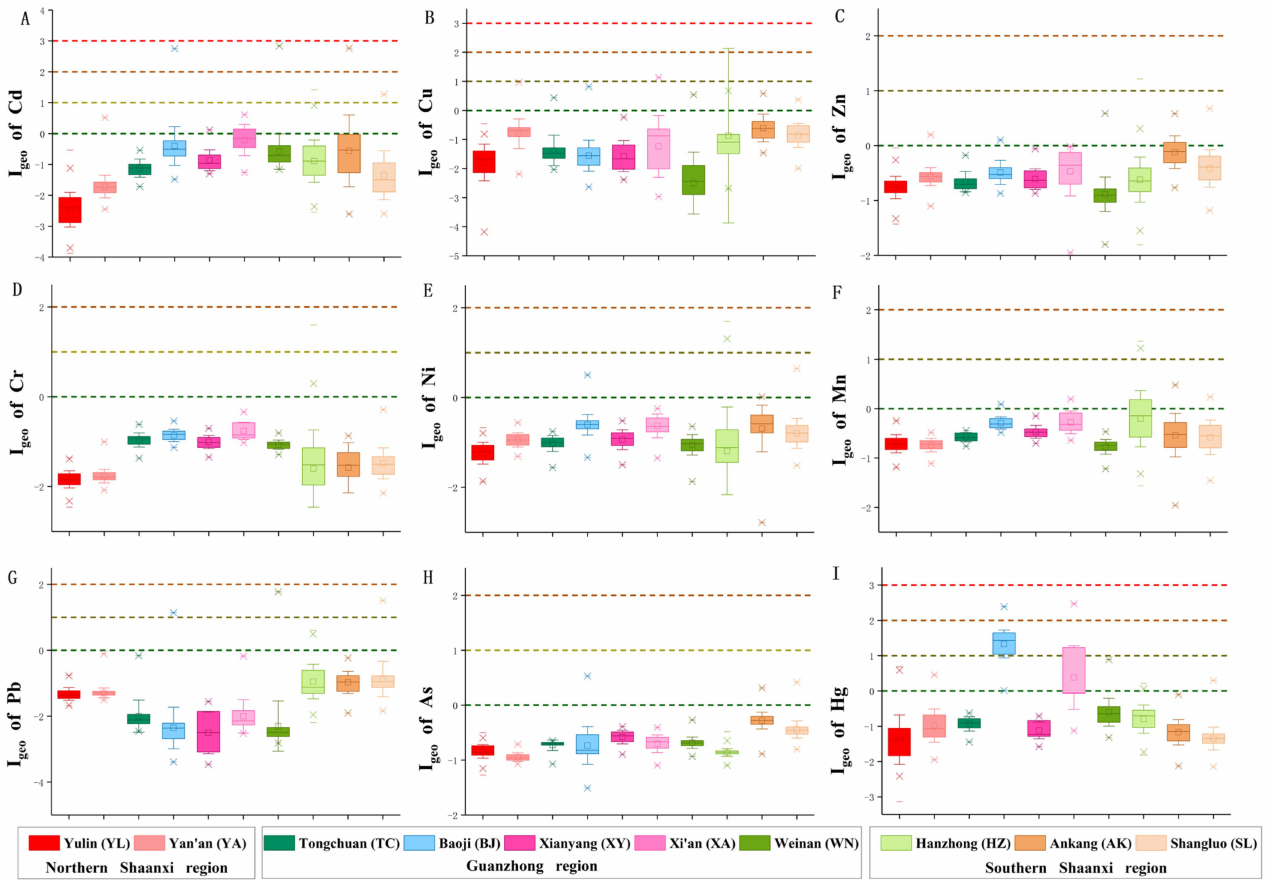
Figure 5. The geo-accumulation index (I geo ) of Cd ( A ), Cu ( B ), Zn ( C ), Cr ( D ), Ni ( E ), Mn ( F ), Pb ( G ), As ( H ), and Hg ( I ) in soil samples. The pollution level standards of I geo are Level 1 (I geo < 0) pollution-free (green line); Level 2 (0 < I geo < 1) mild pollution (yellow line); Level 3 (1 < I geo < 2) mild- to-moderate pollution (orange line); Level 4 (2 < I geo < 3) moderate pollution (red line). Abbreviations are as follows: Yulin (YL, red), Yanan (YA, 50% red), Tongchuan (TC, dark cyan), Baoji (BJ, 50% dark cyan), Xianyang (XY, pink), Xi’an (XA, 50% pink), Weinan (WN, olive), Hanzhong (HZ, 50% olive), Ankang (AK, orange), and Shangluo (SL, 50%